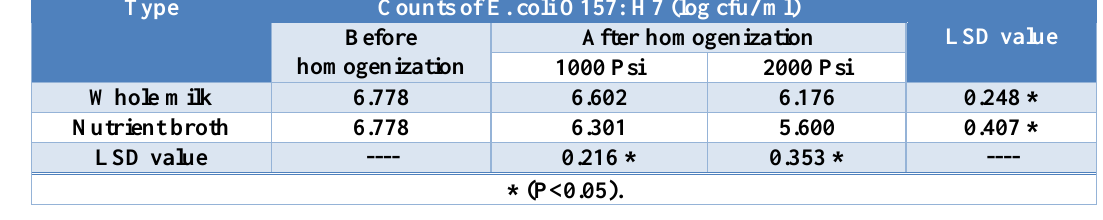
Table, 2: Effect of different homogenization pressures (1000 and 2000 Psi) for five passes on the viability losses of E. coli O157: H7 in milk and nutrient both.